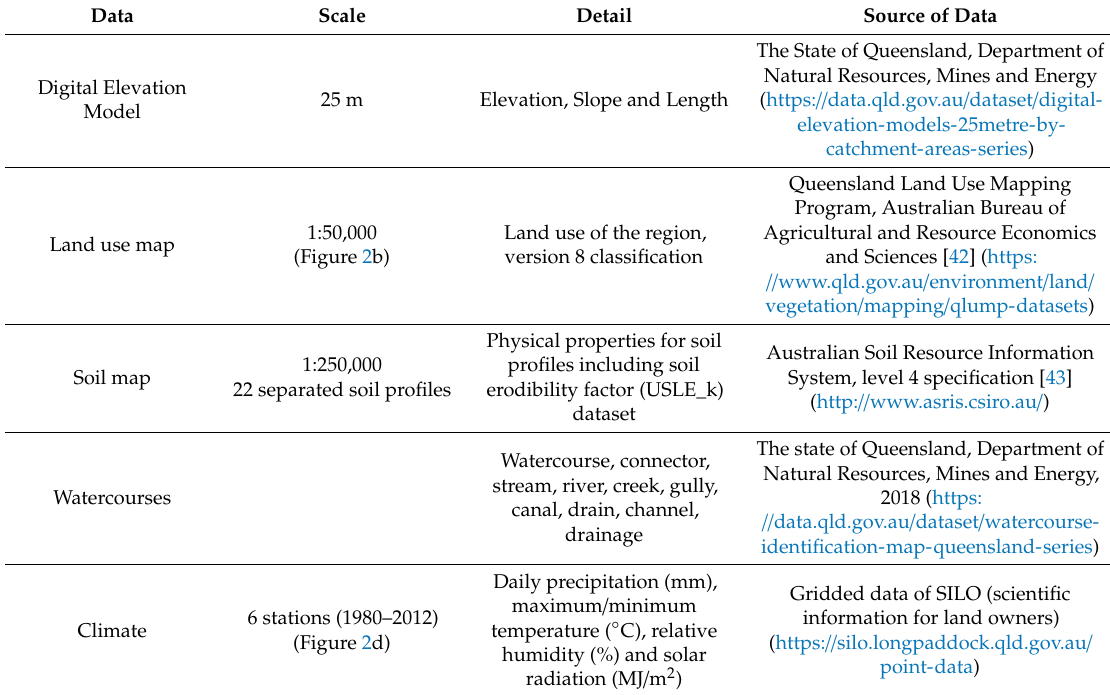
Table 1. Summary of model input